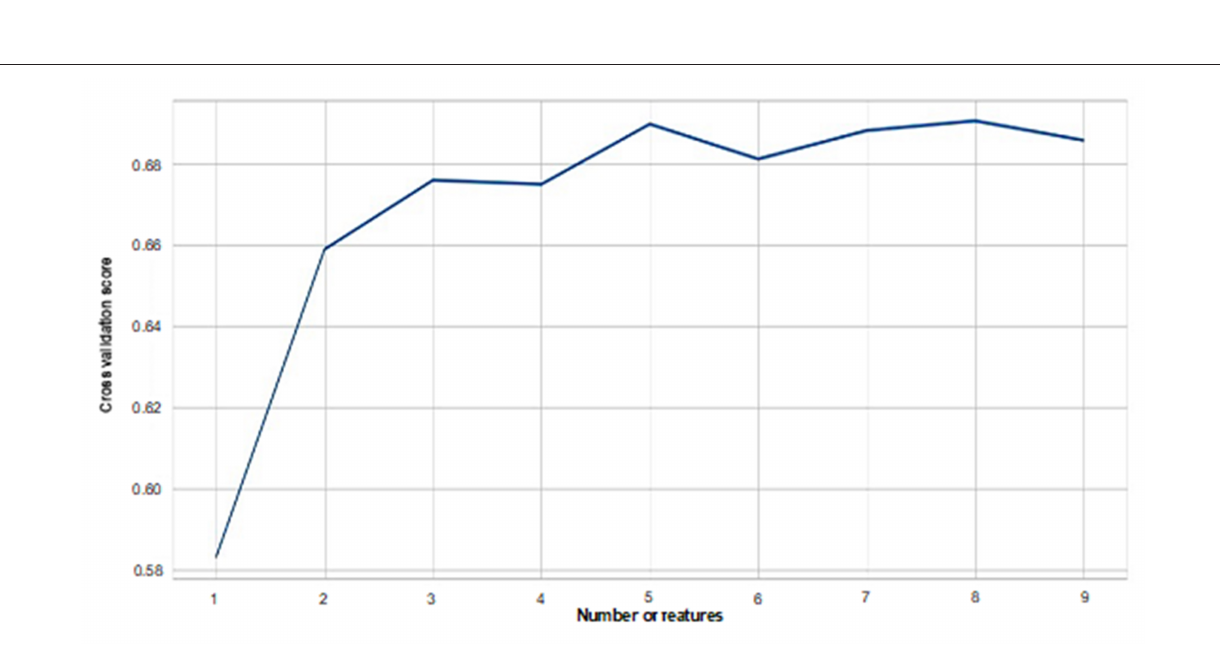
FIGURE 3 | Numbers of features and cross-validation scores of random forest-based prediction of emotions. Cross-validation scores for each number of features used in the prediction of emotions are plotted. As more features are included in the prediction, cross-validation scores increase. A plateau is reached when five features are